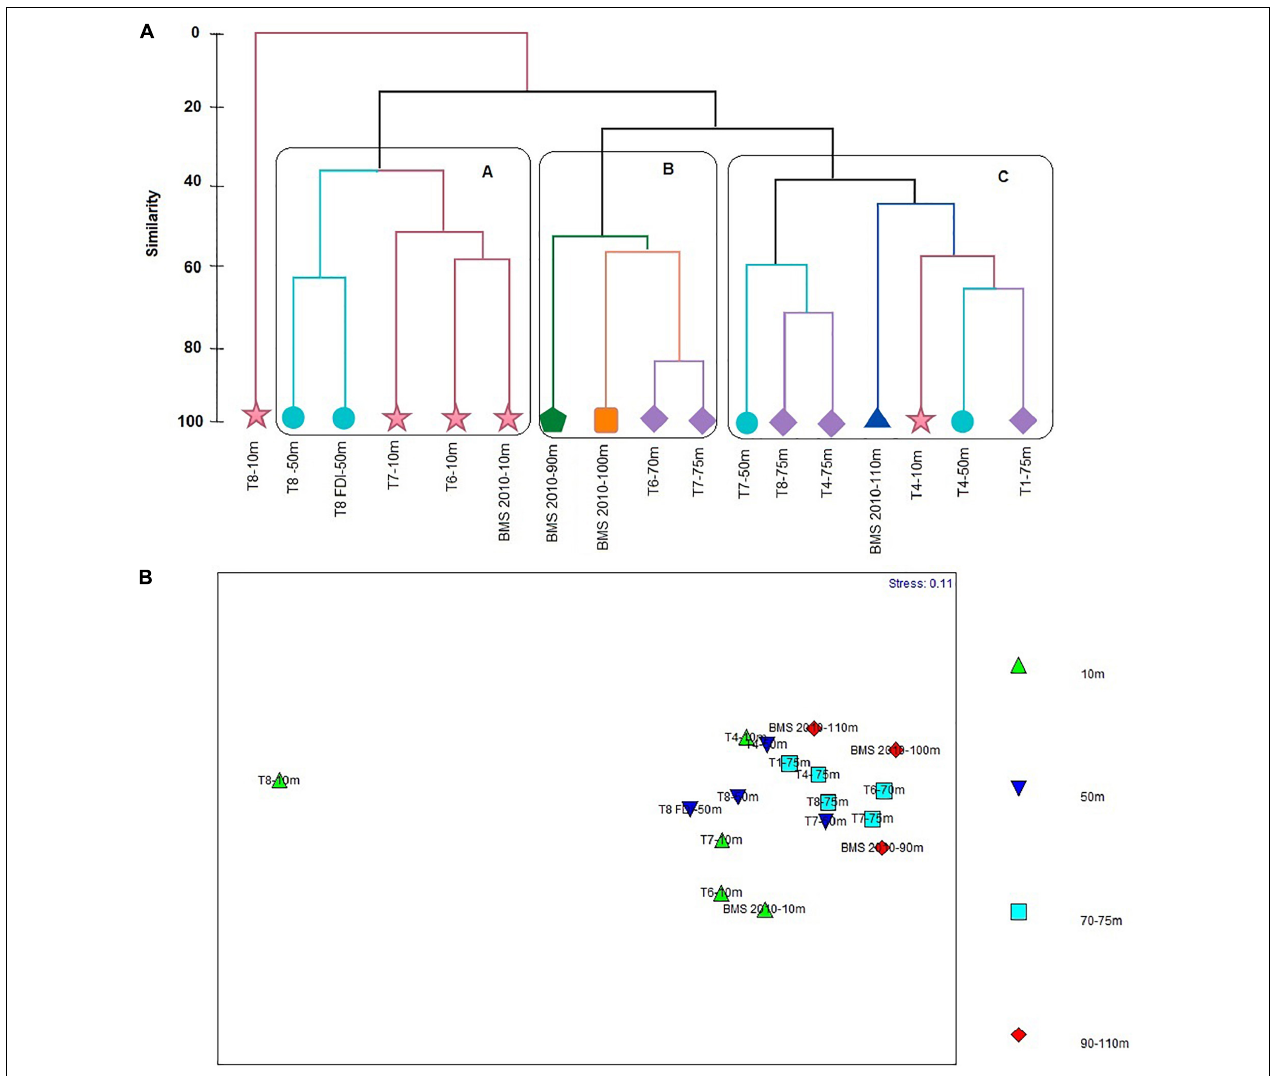
FIGURE 9 | (A) Similarity cluster. (B) Multidimensional Scaling Analysis (MDS) regarding foraminifera species abundances registered in the 17 stations (spatial distribution).